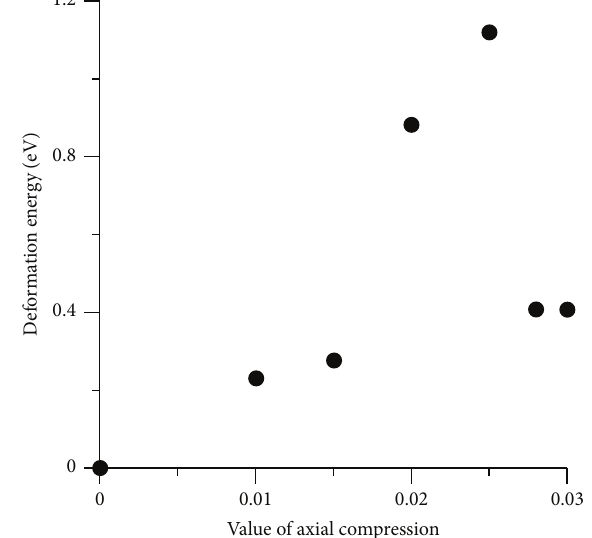
Figure 2: Dependence of the deformation energy on axial compres-